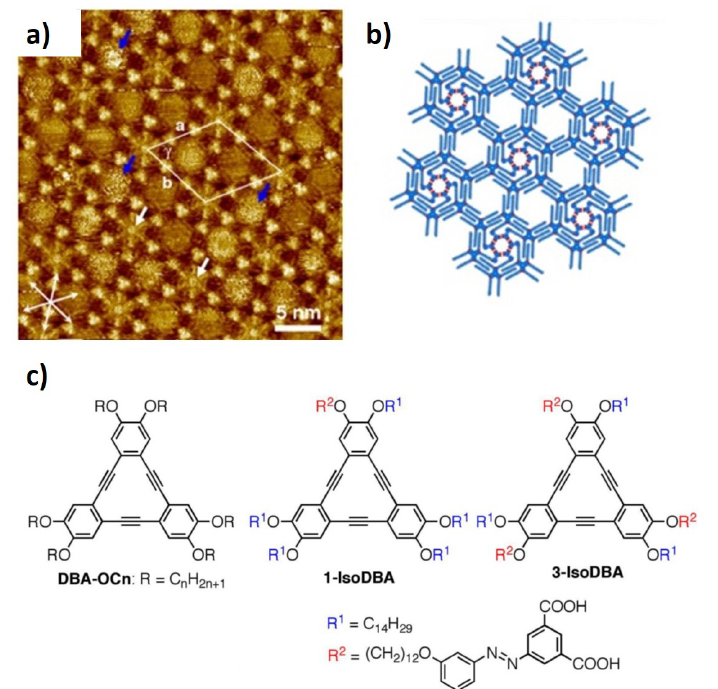
Figure 4. ( a ) STM image of a self-assembled monolayer of DBA functionalized with isophthalic acid linked to the alkyl chains by azobenzene groups. The image shows a honeycomb array characterized by two types of pores: smaller ones indicated by white arrows surrounded by the isophthalic units and larger ones indicated by blue arrows involved by the interdigitated alkyl chains. ( b ) molecular model of the DBA monolayer observed in (a). ( c ) chemical structure of DBA-OCn molecules and the DBA molecules functionalized with isophthalic units (1-IsoDBA and 3-IsoDBA) (Reproduced with permission from reference [43] Copyright from 2016 American Chemical